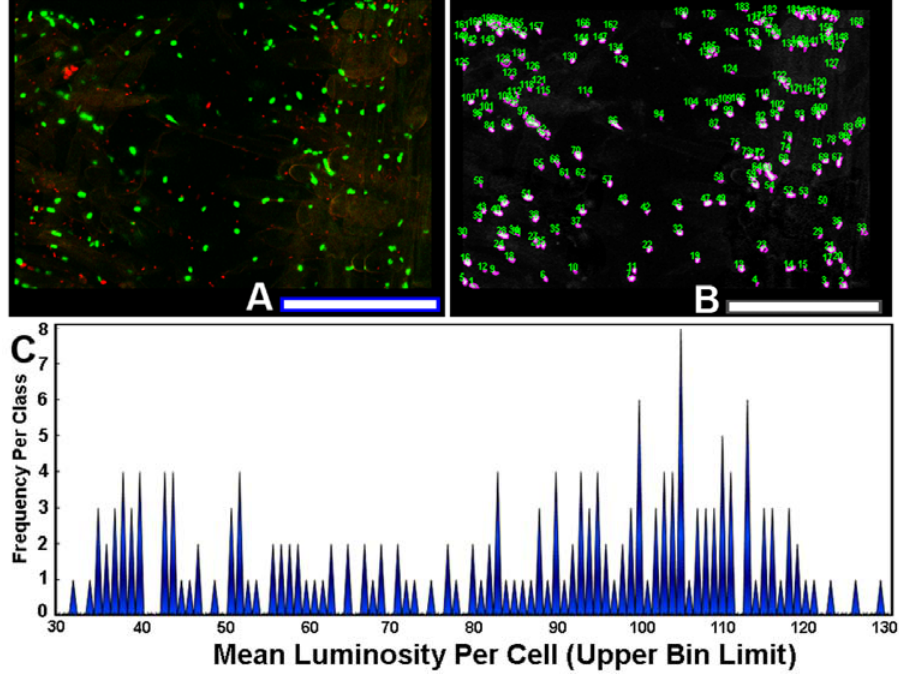
Figure 8. ( A ) Red fluorescent AHL-source and green fluorescent AHL-sensor strains colonized on a tomato root surface; ( B ) Color segmented and annotated cells of green fluorescent AHL-sensor cells; ( C ) Frequency distribution of the mean luminosity per green fluorescent AHL-sensor cell. Bar scales equal 100 μ